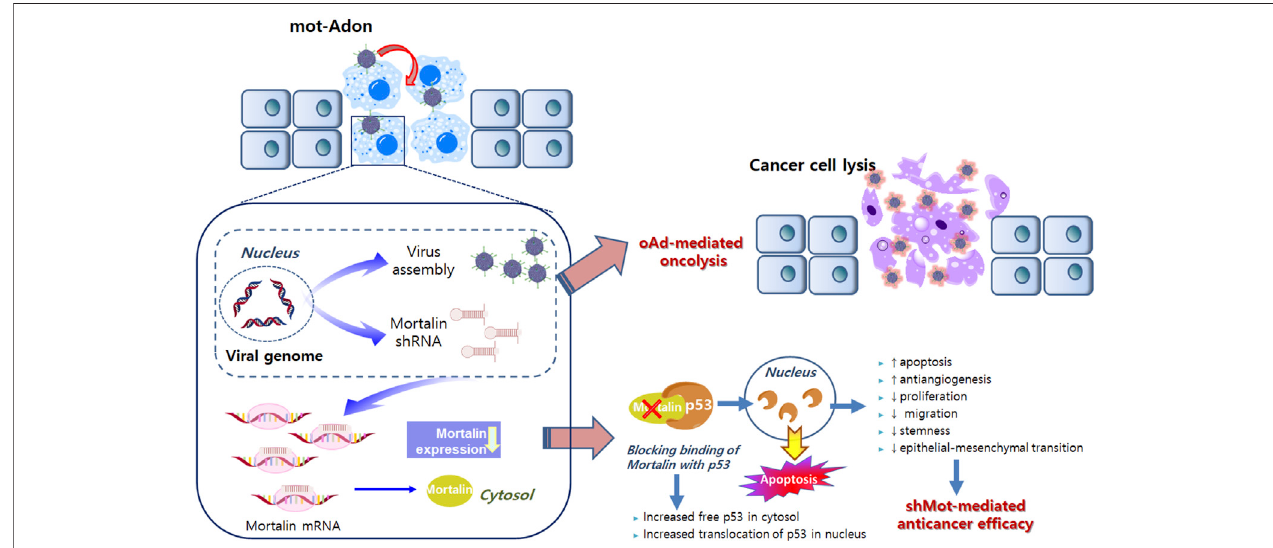
FIGURE1| Mortalin-expressingoncolyticadenovirus.Activeinfectionandreplicationofoncolyticadenovirusintumorcellsresultsintumor-speci fi cviralreplication and oncolysis. Along with viral replication, the expression of shorthairpin RNA (shRNA) against mortalin is also restricted in cancer cells, resulting in decreased non- speci fi cexpressionofshRNAandadversesideeffects.shRNAagainstmortalincanreducetheproliferation,migration,stemness,andepithelial – mesenchymaltransition, whileenhancingtheanti-angiogenesisandapoptosisincancercells.Collectively,oncolyticadenovirus-mediatedoncolyticpropertiesandshRNAagainstmortalin- mediated anticancer properties can synergistically regulate the anti-tumor effects on cancer cells.